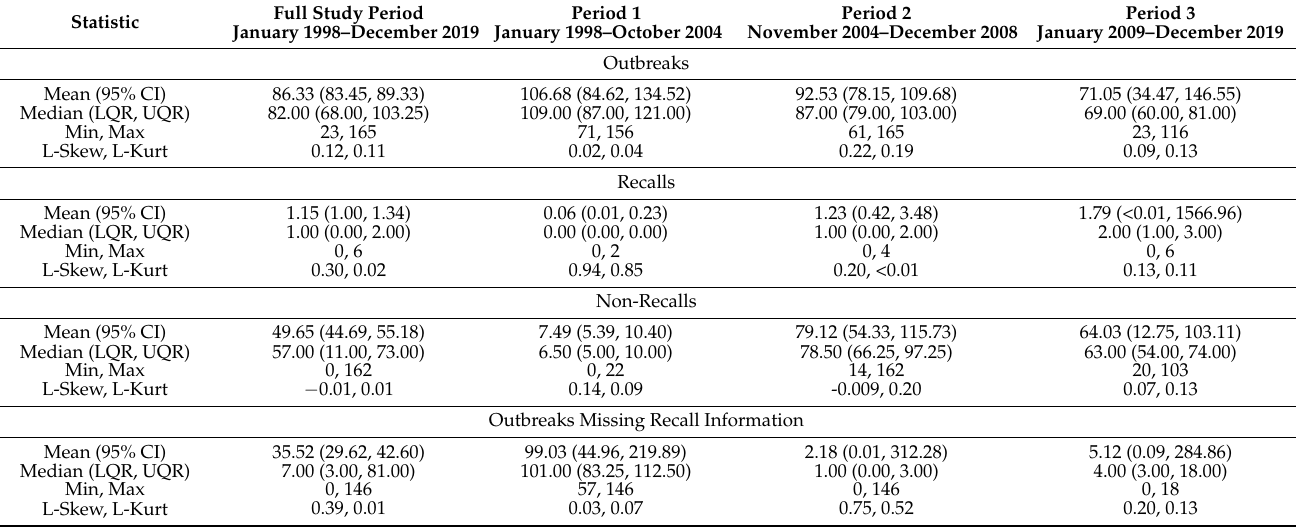
Table 2. Summary statistics for monthly outbreaks, recalls, non-recalls, and outbreaks missing recall information, as reported by the electronic Foodborne Outbreak Reporting System (eFORS) and National Outbreak Reporting System (NORS) in